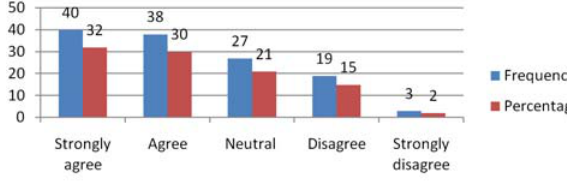
Fig. 7. Banks ignoring SMEs request for loans